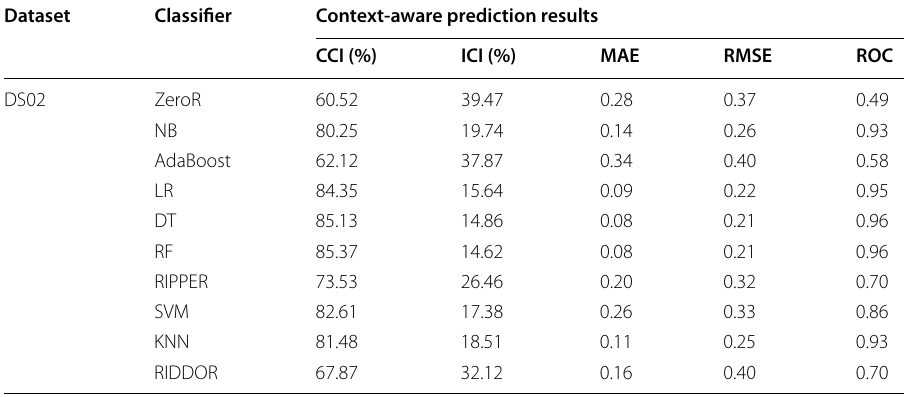
Table 2 Prediction results using various machine learning classification models utilizing dataset DS02 Dataset